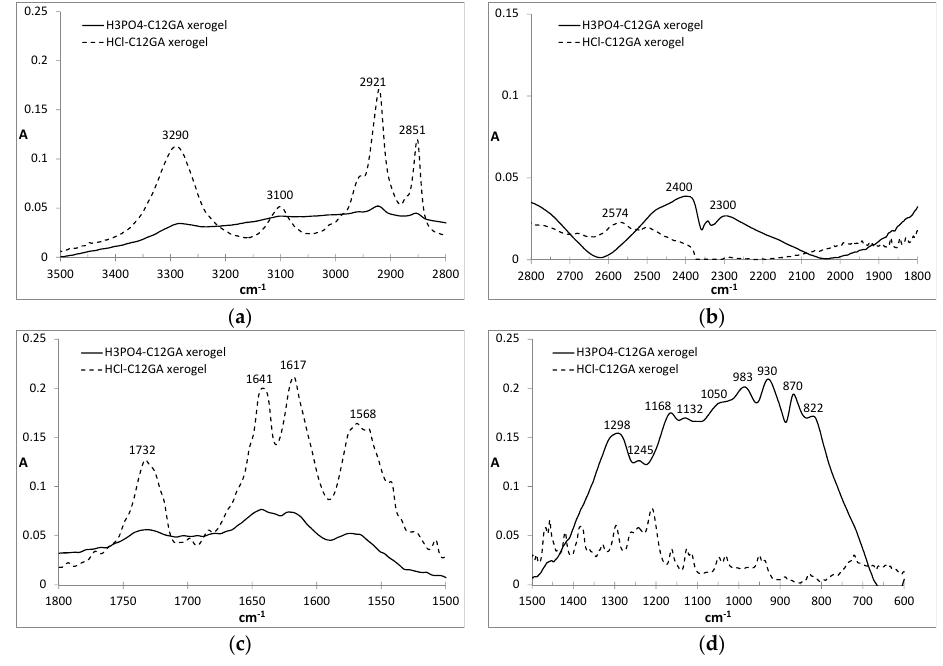
Figure 3. FTIR spectra of C12GA dried xerogels obtained in acidic media: HCl (dashed line), H 3 PO 4 (solid line): ( a ) 3500-2800 cm − 1 ; ( b ) 2800-1800 cm − 1 ; ( c ) 1800-1500 cm − 1 ; ( d ) 1500-600 cm − 1 .